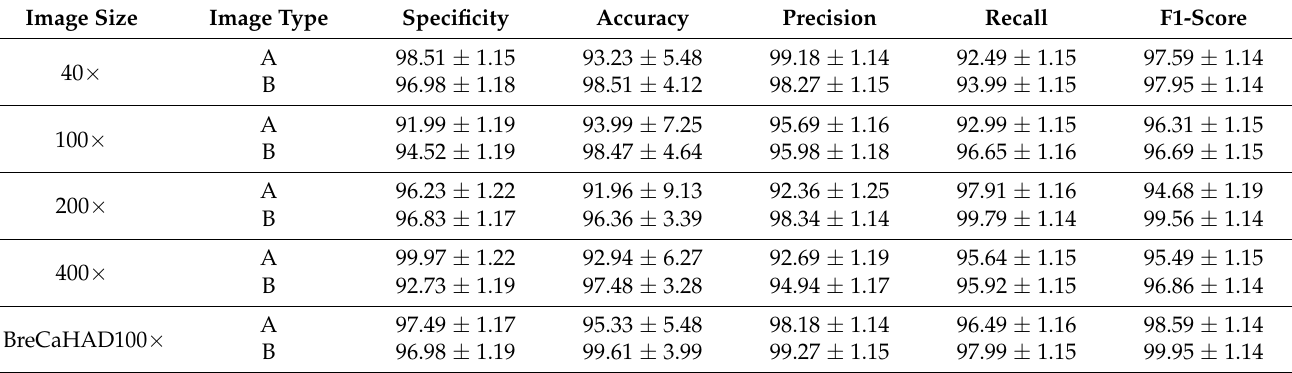
Table 3. The Proposed Model’s Evolution